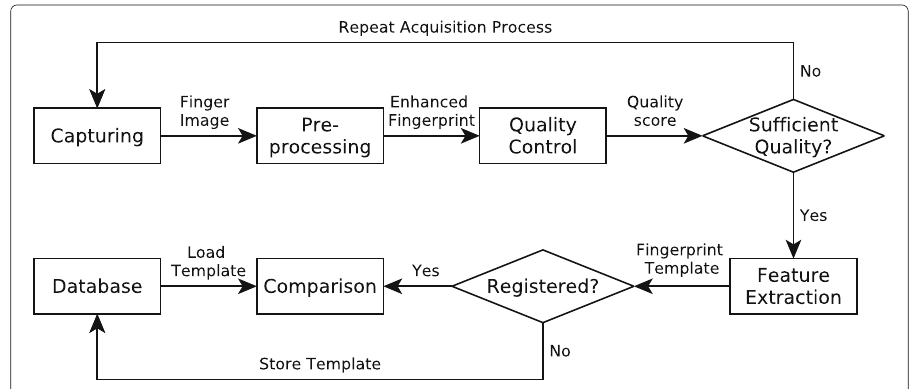
Fig. 2 Modules of fingerprint recognition. Overview on the main modules (sub-systems) of a generic touchless fingerprint recognition system